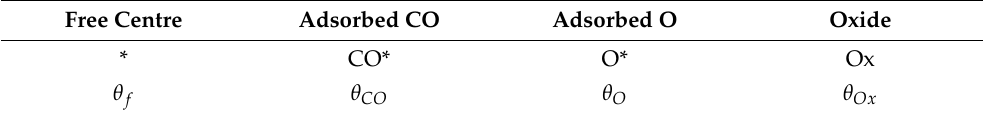
Table 1. List of the species on the Pt foil surface and the corresponding coverages ( θ i ). Free Centre Adsorbed CO Adsorbed O Oxide * CO* O* Ox θ f θ CO θ O θ